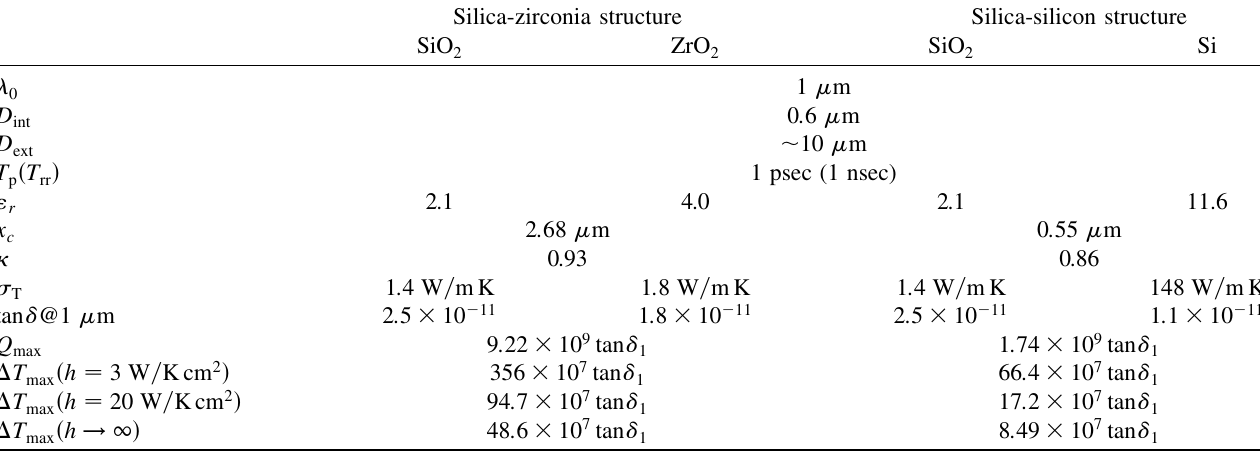
THERMAL SCALING LAWS OF THE OPTICAL BRAGG . . TABLE II. Parameters used for the simulations presented in Figs. 5–8, and maximum values of the temperature and heat flux. Silica-zirconia structure Silica-silicon structure